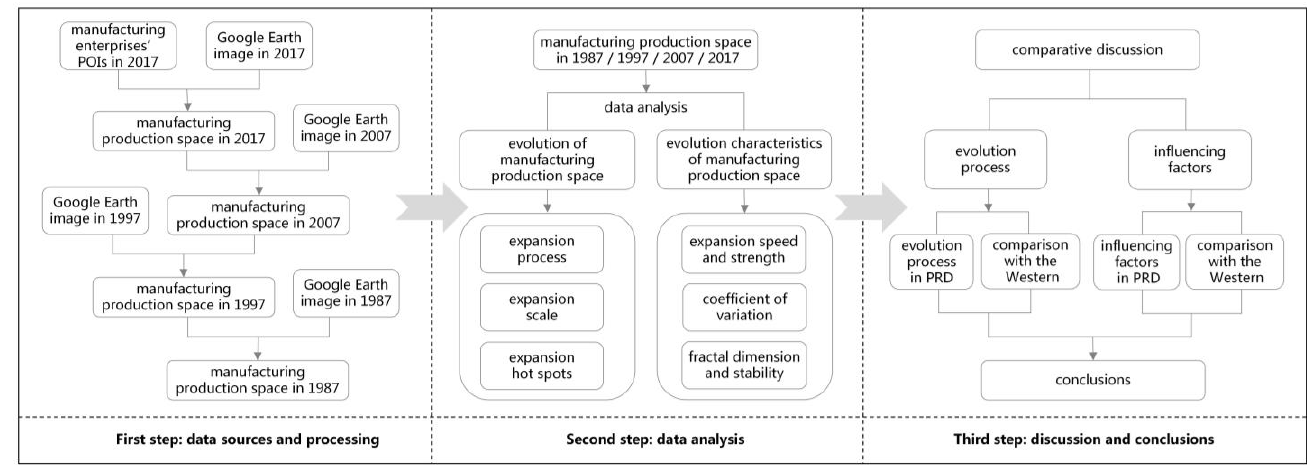
Figure 4. Workflow schema.